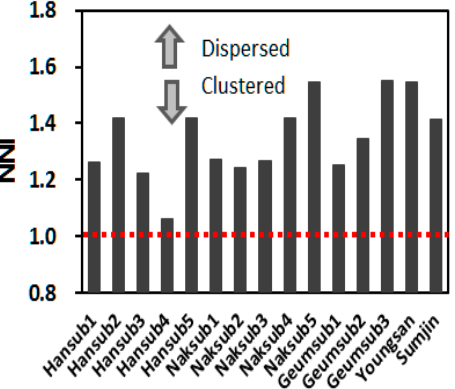
Figure 3. Comparison of NNIs of Each Basin to Evaluate the Spatial Distribution.